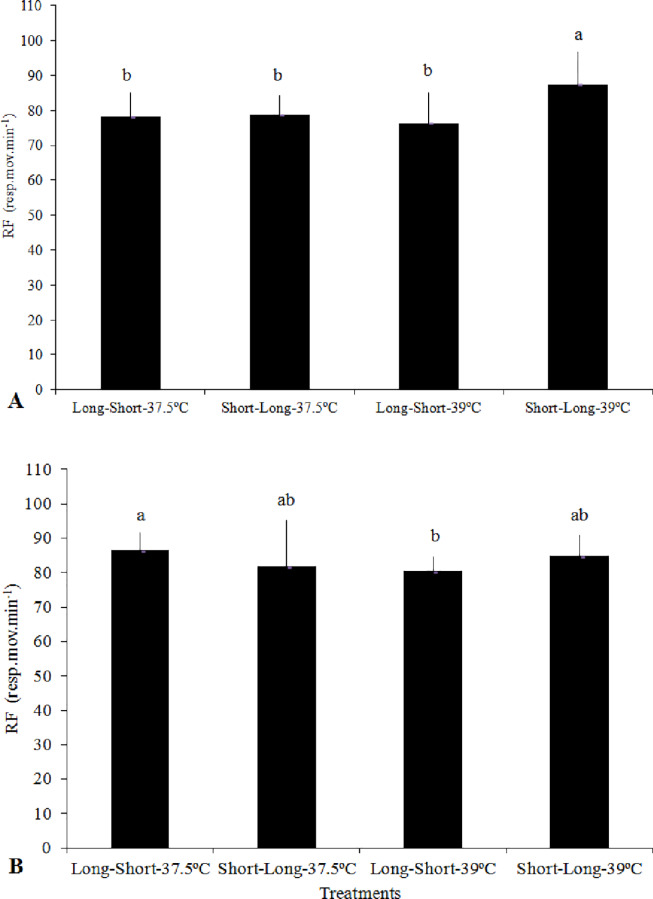
Respiratory frequency (RF) of broilers aged 8 (A) and 29 (B) days, at the end of the thermal challenge phase, with the hatching pattern (Short-Long or Long-Short) and the incubation temperature (37.5°C or 39.0°C from day 13). Short-Long and Long-Short: Time intervals between pippings and between external pipping and hatching (2-8h10min+20-26h and 11–18+6-10h, respectively). a-b: means with similar letters do not differ from each other (Tukey test, P ≤ 0.05).